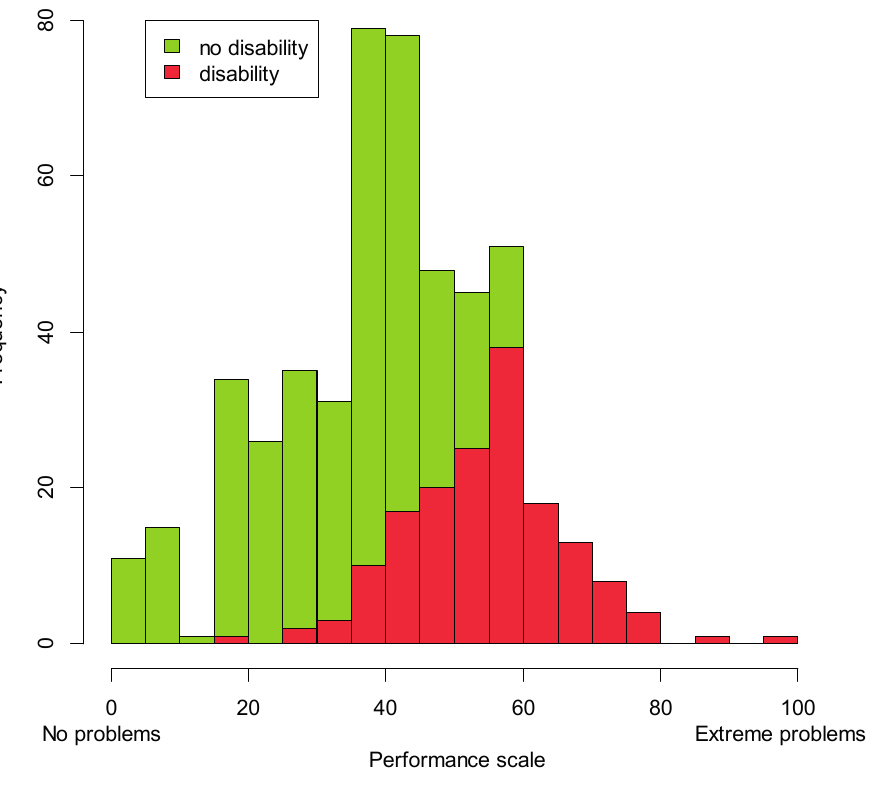
Figure 3. Distribution of the sample on the performance scale; groups generated with the screener